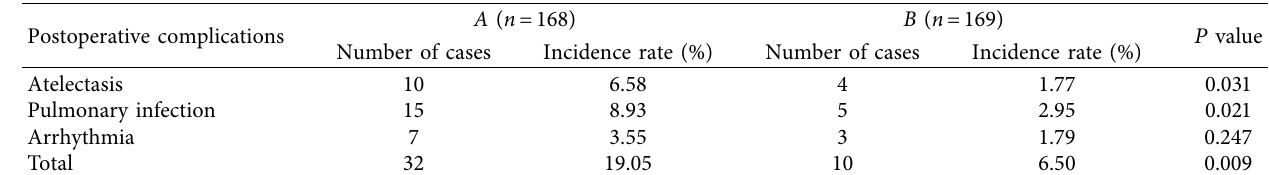
Table 4: Comparison of postoperative complications.